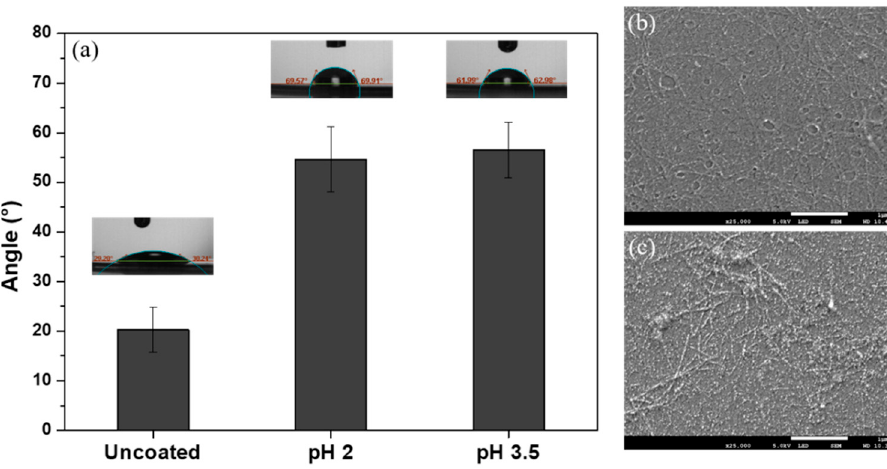
Figure 2. ( a ) Contact angle (CA) measurements of uncoated and fibrillar coated samples with solution at pH 2 and pH 3.5 and SEM images of fibrillar coatings obtained at ( b ) pH 2 and ( c ) pH 3.5 (scale bar: 1 μ m).